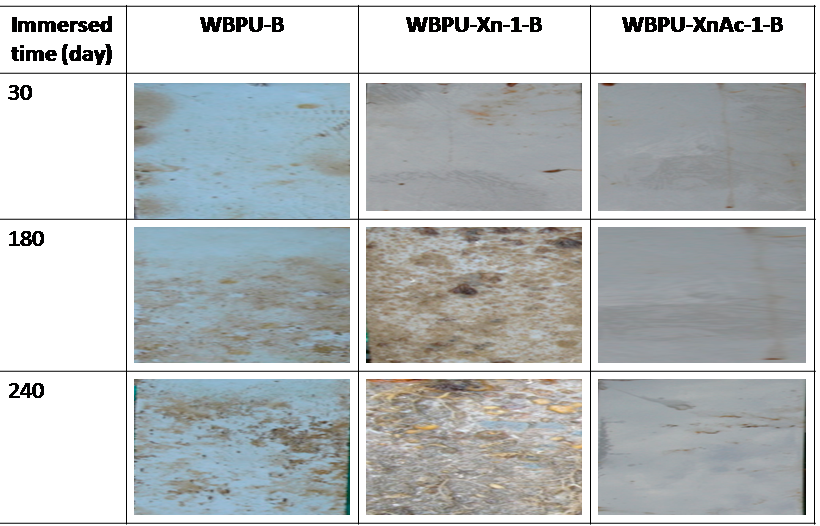
Figure 8. Photographs of exposed coatings with defined interval.